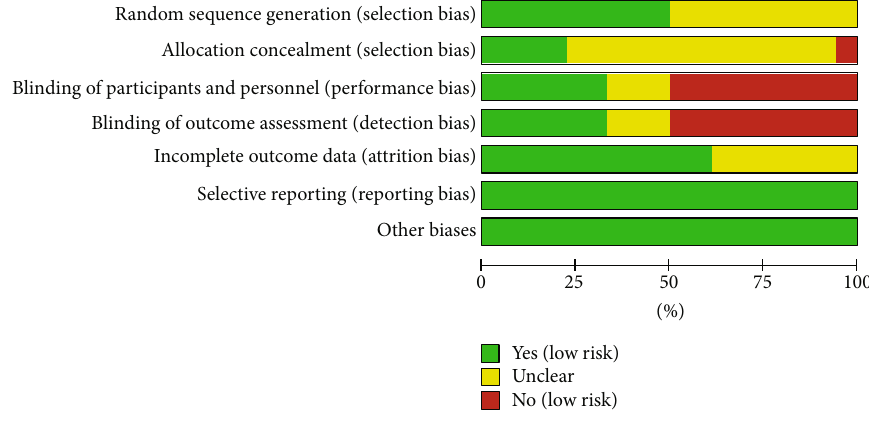
Figure 2: Risk of bias